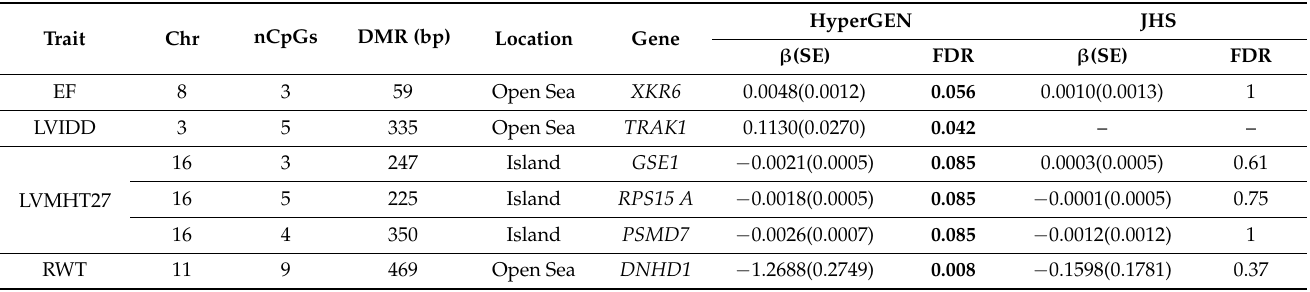
Table 2. Statistically significant DMRs by LV